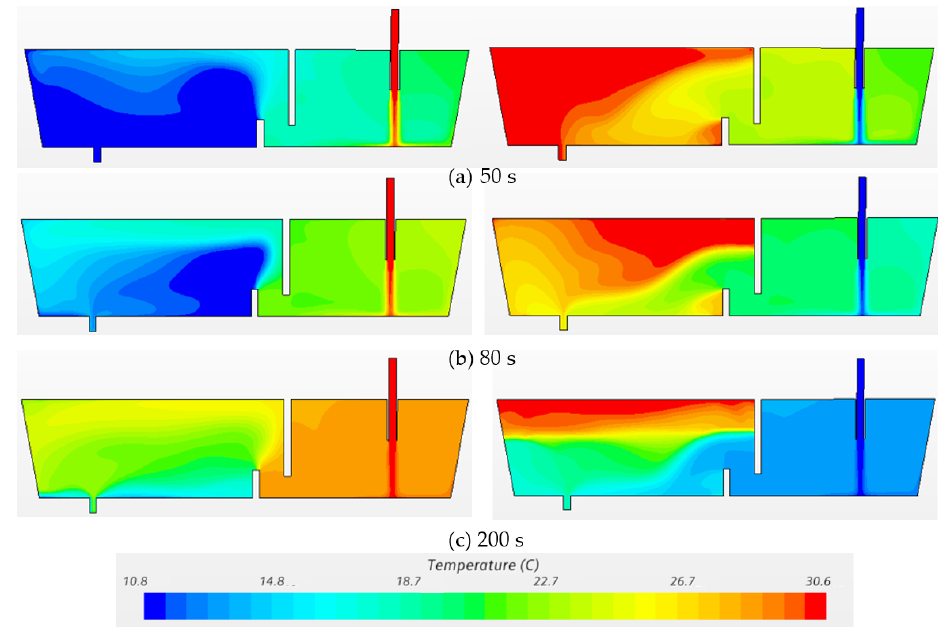
Figure 9. Temperature profiles at symmetry plane under transient non-isothermal conditions in water model with FCD (Q = 2000 L/h, H = 0.4 m, left: ΔT = 20 °C, right: ΔT = −20 °C). ( a ) 20 s, ( b ) 80 s, ( c ) 200 s.